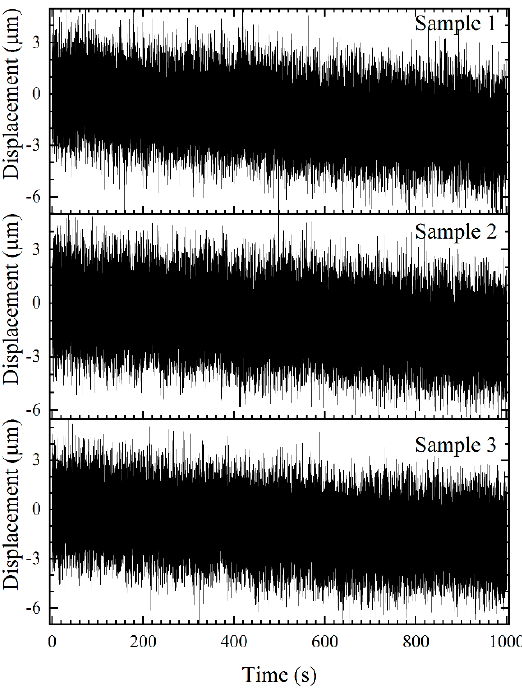
Figure 11. The intrinsic drift of the balance during 1000 s.